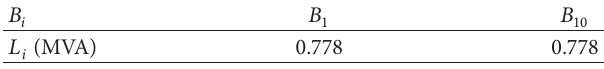
Table 4: Distance to boundaries of 𝐵 1 and 𝐵 10 at W 󸀠 1